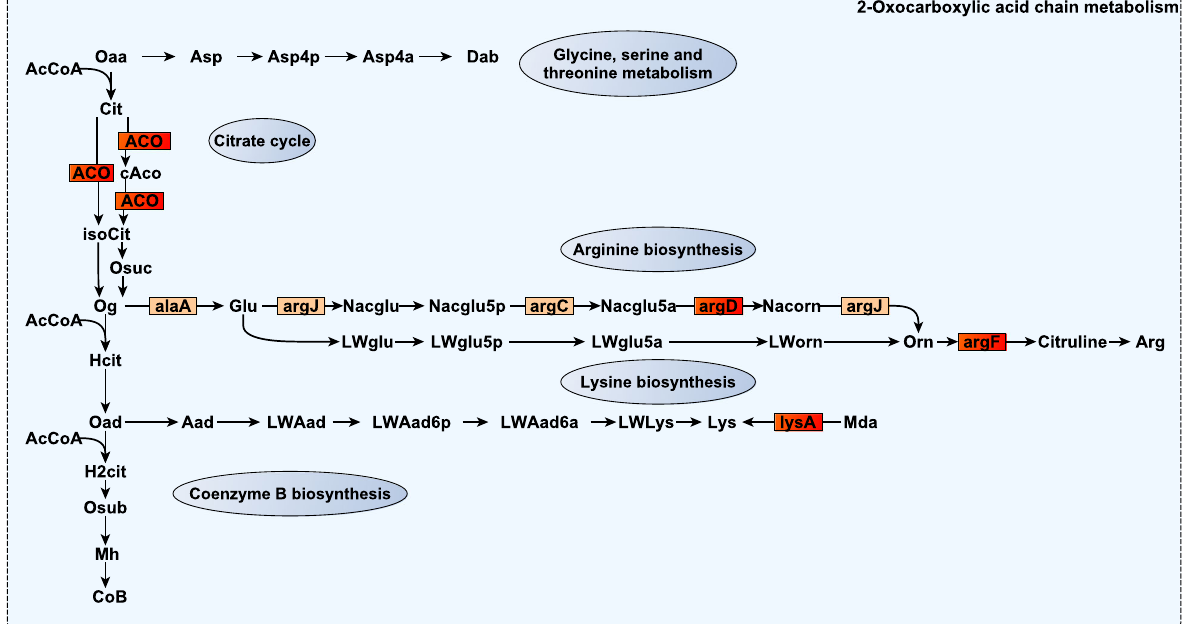
Fig. 2 Reaction scheme of 2-oxocarboxylic acid metabolism and glycine, serine, threonine, arginine, lysine, and Coenzyme B biosynthesis in which additive log-ratio transformed microbial gene abundances strongly host-genomically correlated with methane emissions ( r gCH4 ) are involved. Small rectangles symbolize proteins encoded by the microbial genes. Microbial genes are highlighted in red when their r gCH4 estimates range between − 0.74 and ≥ 0.95, and in orange when they range between |0.55| and |0.77| and P ≥ 0.85. Source data is − 0.93 and show a probability of being different from 0 ( P 0 ) 0 in Supplementary Data 9. Compounds are denoted by their short names. Full names of compounds and microbial genes are given in Supplementary Data